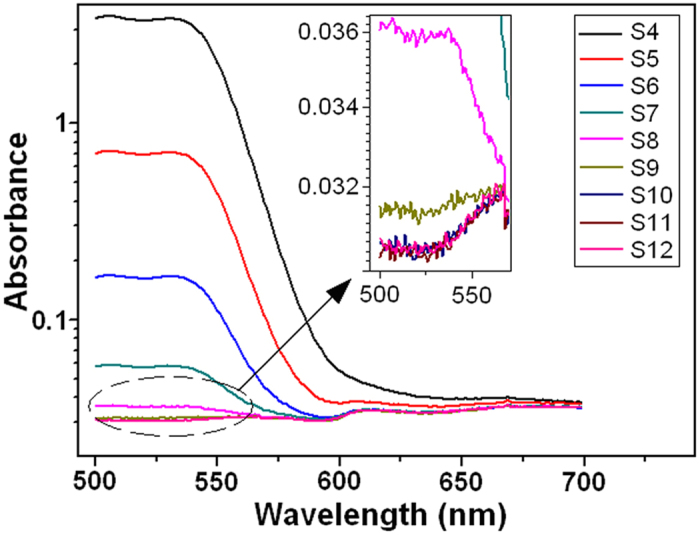
Measurement results of the red-ink samples by using the spectrophotometer.